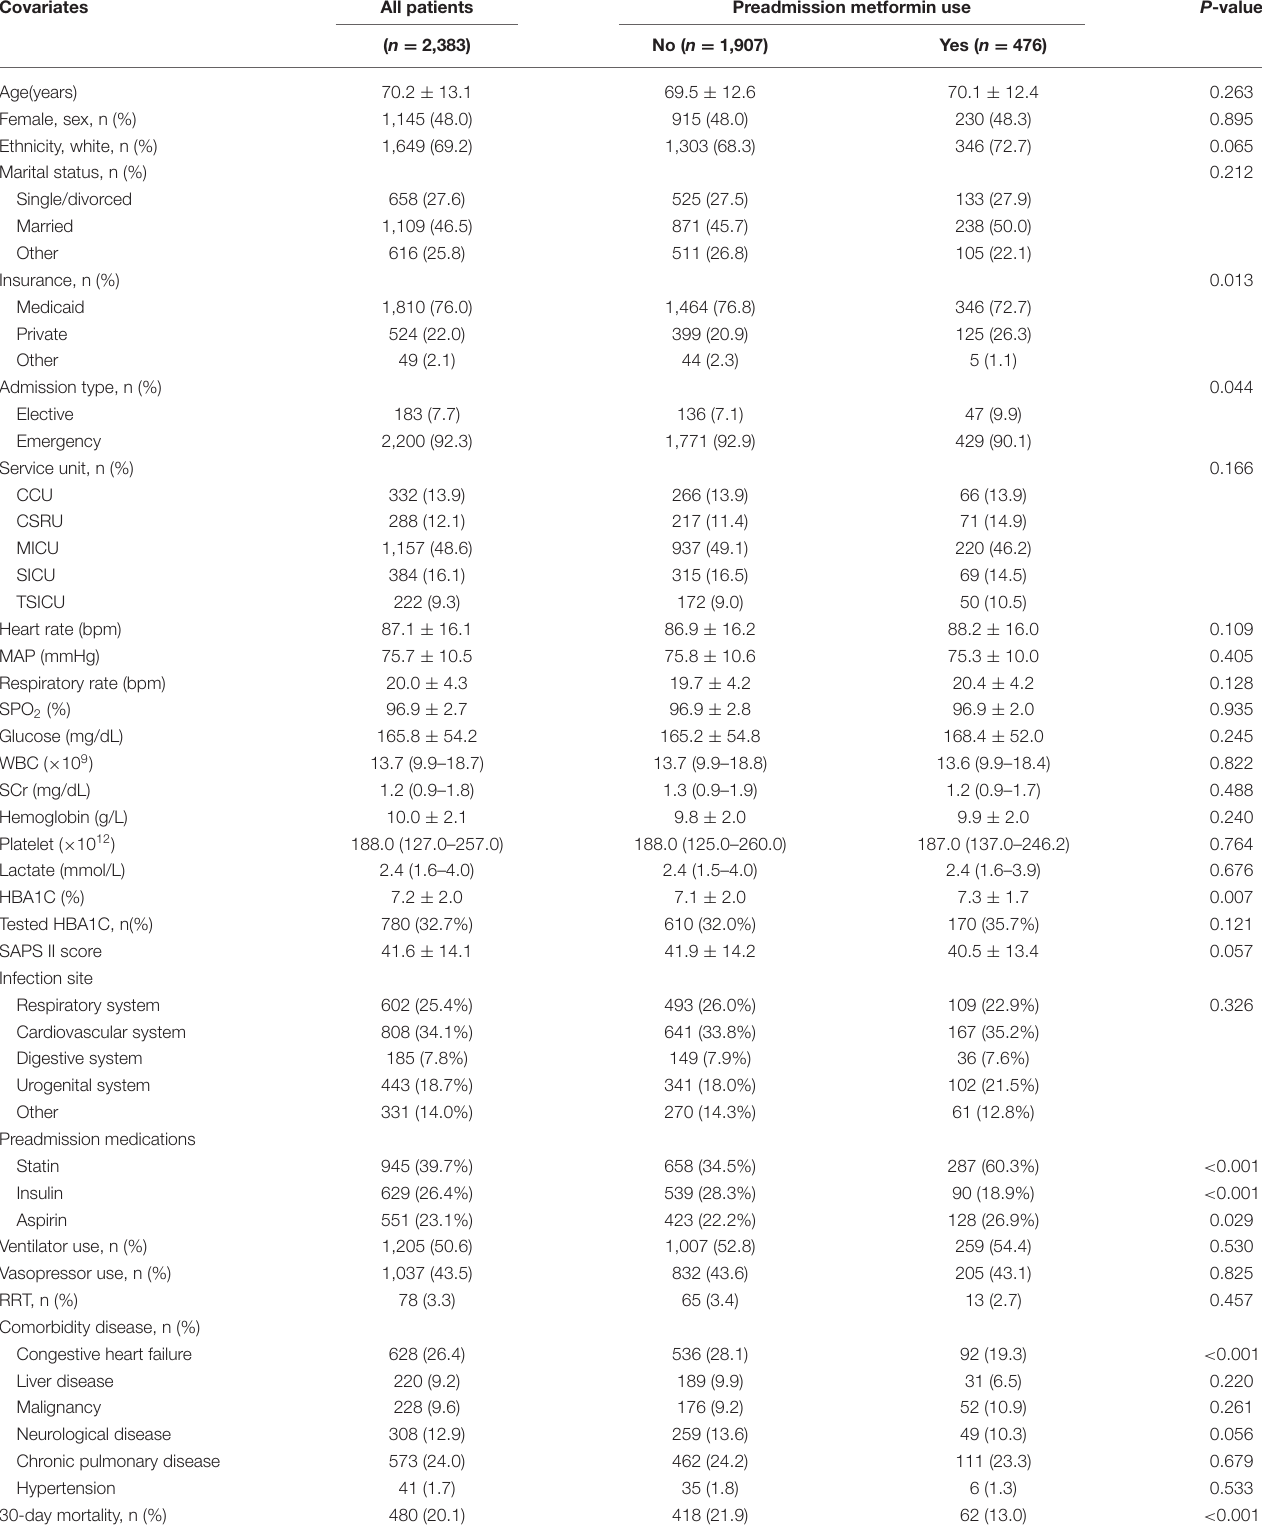
TABLE 1 | Baseline characteristics of participants.